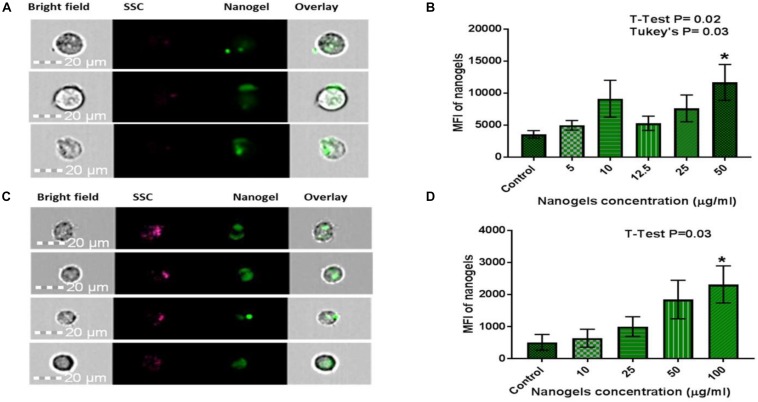
Qualitative and quantitative assessment of cellular uptake of nanogels using Flow Cytometry for (A,B) CHME-5: Statistical analysis: Data is represented as Mean ± SEM. Significance was tested by Student’s T-test which showed T4 50 μg/ml was significantly higher than Control (P = 0.02). Significance was also tested by one-way ANOVA which showed significance between columns (treatments), F(5, 28) = 2.786, P = 0.0365. Post hoc analysis with Tukey’s multiple comparisons tests showed T4 50 μg/ml was significantly higher than control (P = 0.03). (C,D) PBMCs: Statistical analysis: Data is represented as Mean ± SEM. Significance was tested by Student’s T-test which showed T4 100 μg/ml was significantly higher than Control (P = 0.03). Significance was also tested by one-way ANOVA which showed significance between columns (treatments), F(4, 23) = 2.995, P = 0.03. Post hoc analysis with Tukey’s multiple comparisons tests did not show any further significance. * means it is significant compared to control.